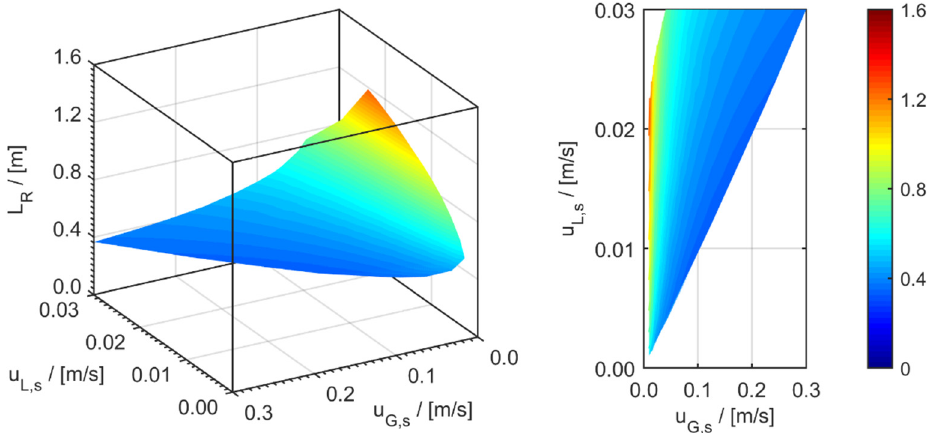
Figure 19. Required reactor length of mini trickle-bed reactors operating at different gas and liquid superficial velocities.